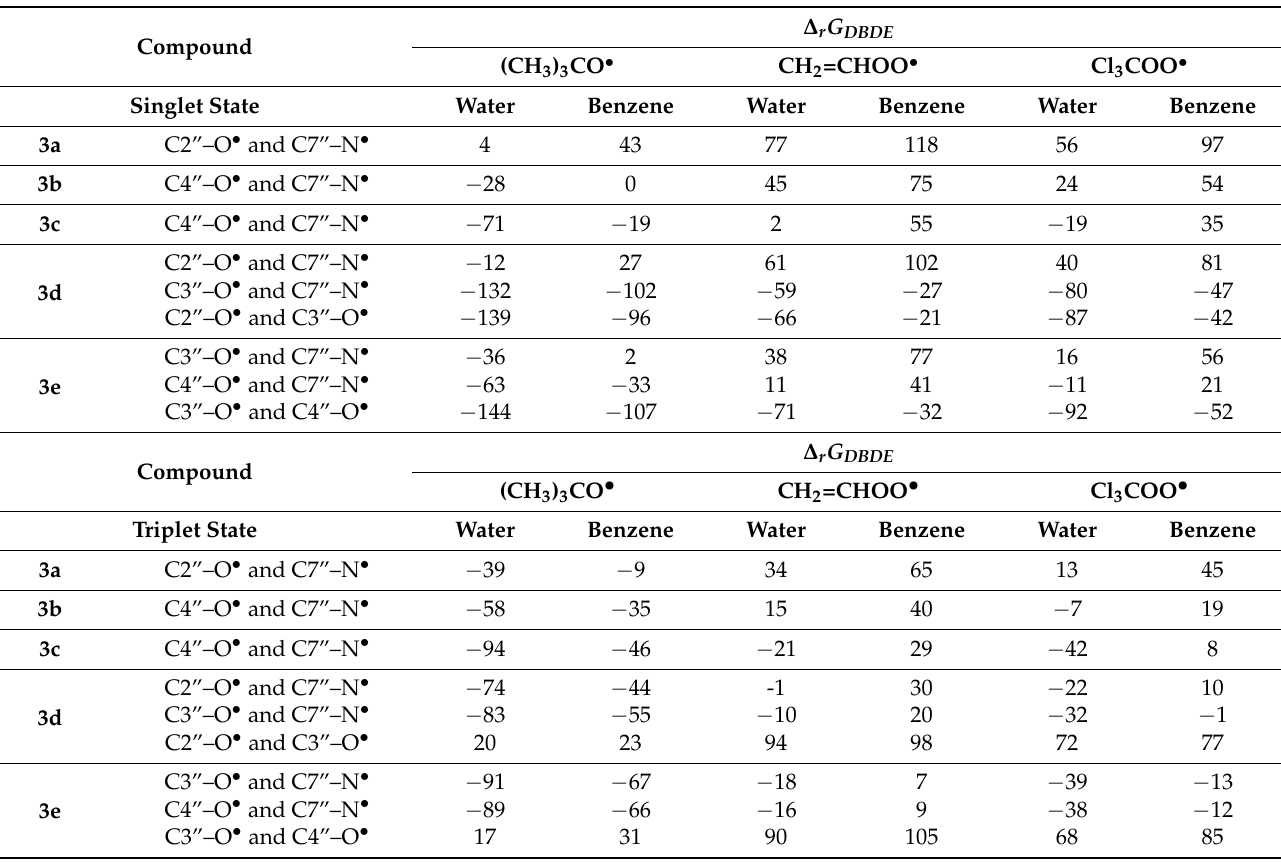
Table 1. Thermodynamic parameters describing the second step of the DHAT mechanism with products in singlet and triplet spin